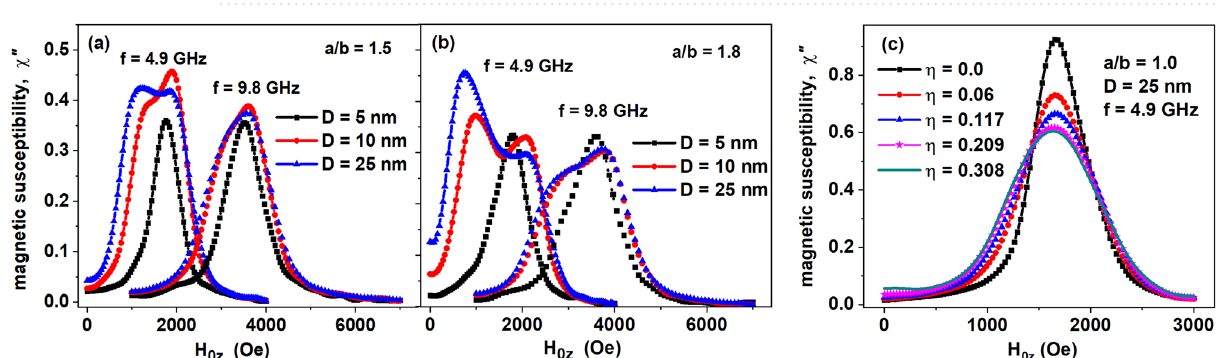
Figure 4. ( a , b ) Change in the FMR spectrum with increase of the excitation frequency from f = 4.9 GHz to 9.8 GHz. ( c ) influence of magnetic dipole interaction on the FMR spectrum in dense clusters of spherical magnetite nanoparticles. The magnetic damping constant κ = 0.1, T = 300